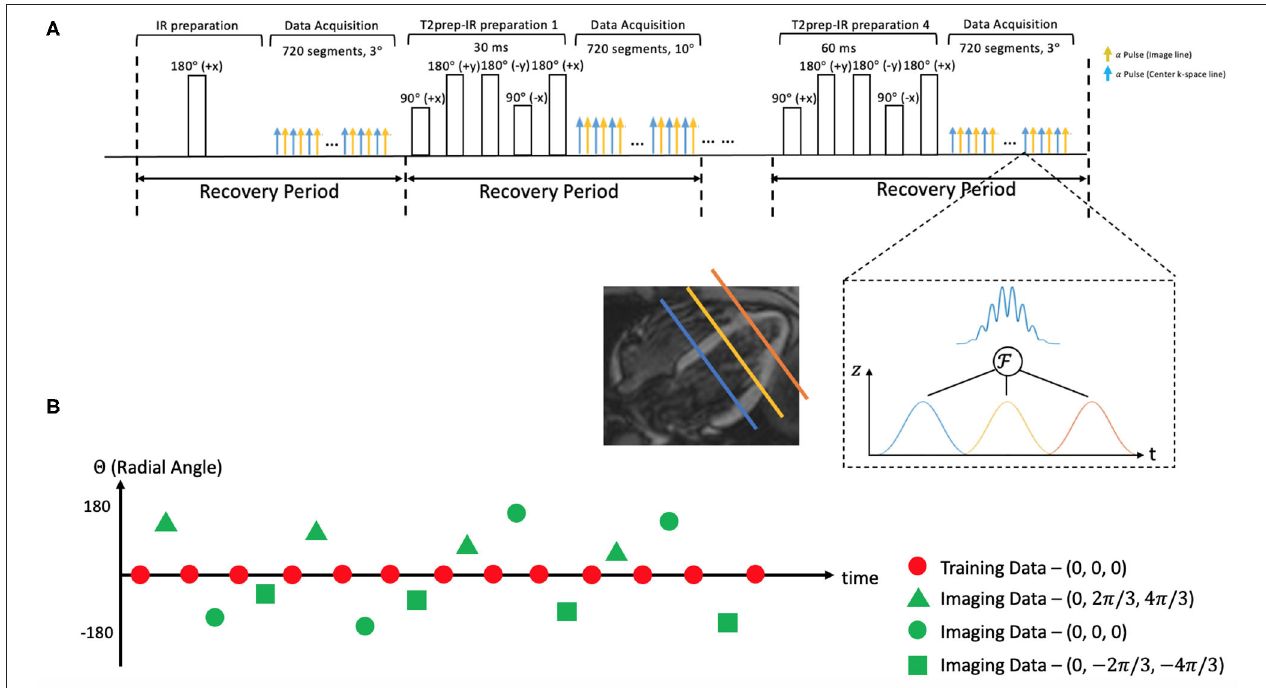
FIGURE 1 | (A) Schematic diagram of the proposed 2D magnetic resonance (MR) Multitasking sequence with simultaneous multislice (SMS)-acceleration, where 5 different preparations (IR and T2prep-IR with 4 different preparation times) are repeated throughout the scan. Each FLASH excitation pulse can excite three slices simultaneously. (B) k-Space sampling demonstration. Imaging data are collected with a 2D radial trajectory, and they are incremented by a golden angle (i.e., 111.24 ◦ ) for each readout. Training data periodically sample the center k-space line every other readouts. Three short-axis slices are excited simultaneously with different phase modulation schemes, resulting in a 2 π/ 3, 0, –2 π/ 3 shift in their phase increment,